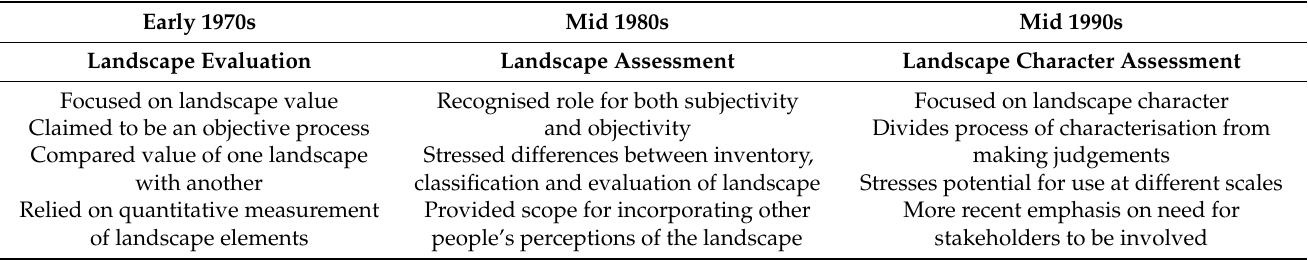
Table 1. Key differences in the evolution of landscape assessment